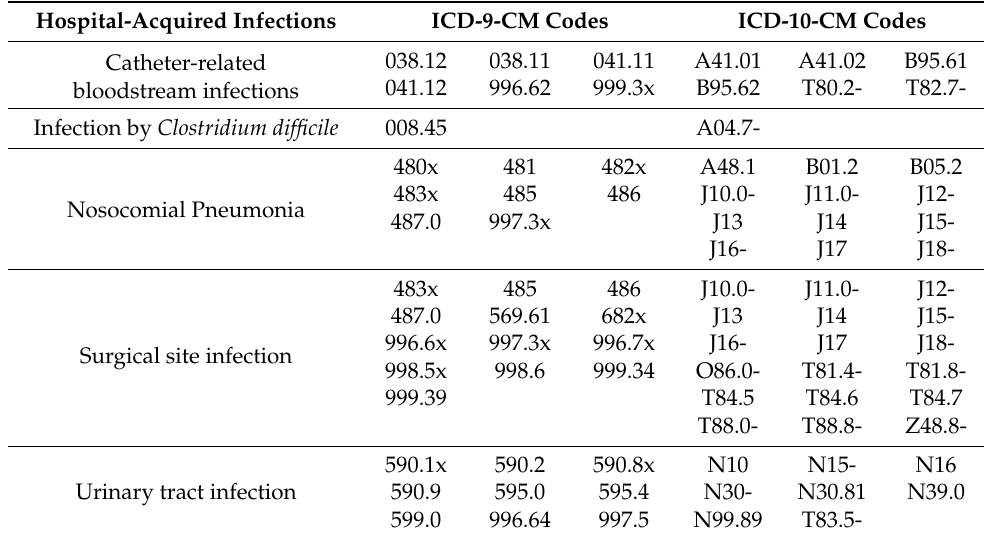
Table 1. ICD-9-CM/ICD-10-CM codes used to identify HAI